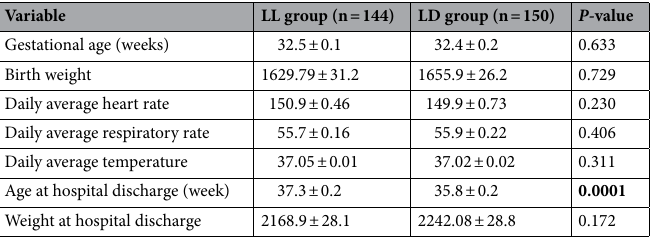
Table 1. Characteristics of infants included in each study arm. Significant values are in [bold].